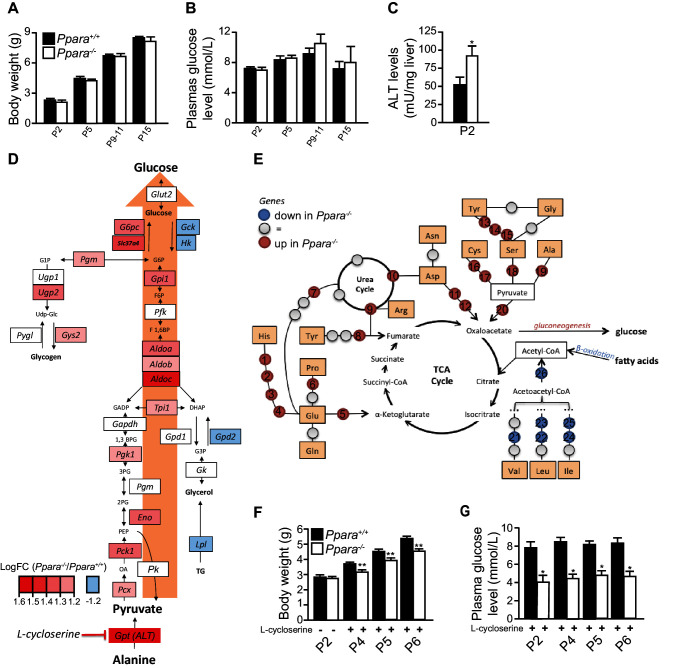
Anaplerotic compensation for defective oxidative metabolism and ketogenesis in suckling Ppara-/-pups.(A,B) Body weight (A) and plasma glucose levels (B) of Ppara+/+and Ppara-/-pups at the indicated postnatal days. (C) Alanine aminotransferase (ALT) activity measured in liver lysates at P2. (D) Gluconeogenesis pathway in Ppara-/-liver at P2 with the supply of pyruvate through the anaplerotic metabolism of alanine indicated. (E) The affected amino acid oxidation pathways in Ppara-/-liver at P2. Colors indicate up-regulation (red) or down-regulation (blue) of genes identified by microarray analysis. The up-regulated genes are Hal (1), Uroc1(2), Amdhd1 (3), Ftcd (4), Glud (5), Pycr (6), Oat (7), Fah (8), Asl (9), Ass1 (10), Got2 (11), Got1 (12), Sds (13), Cth (14), Cbs (15), Cdo1 (16), Got1 (17), Sds (18), Gpt (19), Pcx (20). The down-regulated genes are Ehhadh (21,22,24), Hibch (23), Hmgcs2 (25), Hmgcl (26). (F,G) Body weight (F) and blood glucose (G) of P2pups before and after daily intraperitoneal injections of 30 mg/kg L-cycloserine for two days (P4), three days (P5), and four days (P6). Bars represent means ± SEM; n = 4–6, *p<0.05, **p<0.01 vs. wild-type controls (two-way Mann-Whitney test).